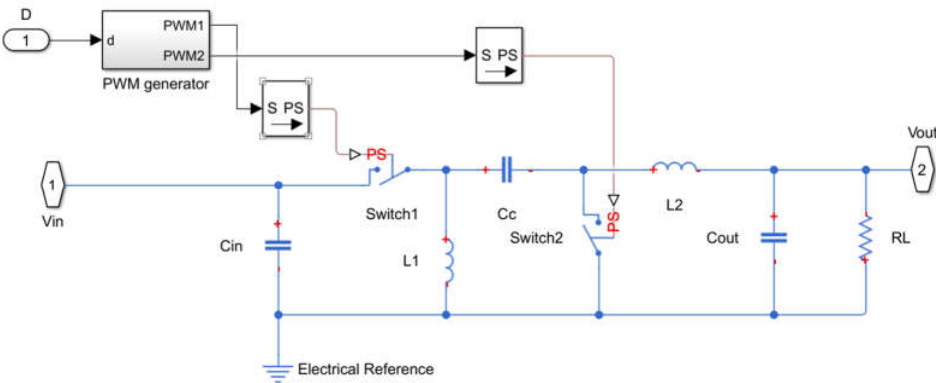
Figure 13. Circuit simulation model of the Zeta type buck-boost converter.